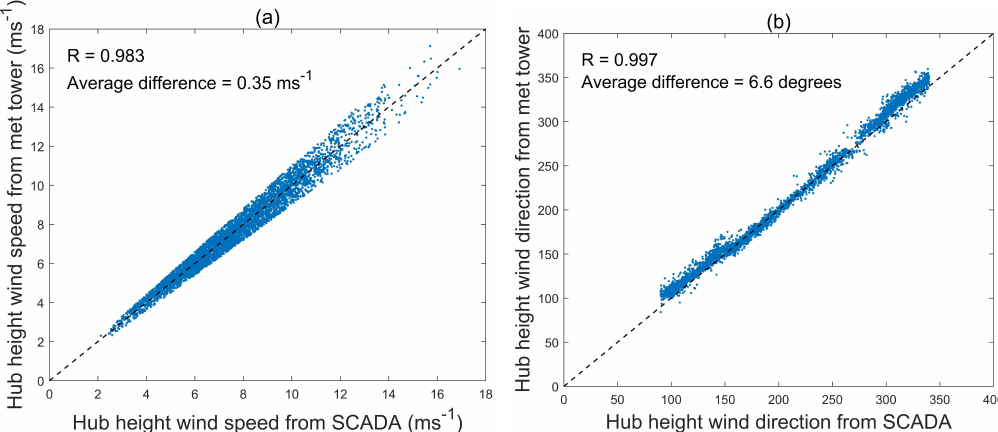
Figure 6. Ten-minute averaged Hub height ( a ) wind speed and ( b ) wind direction measurements from SCADA and met tower data after preliminary quality checks. The dashed diagonal line shows a 1:1 relationship. It should be noted that wind direction at hub height from met tower was not available during the period of study due to sensor failure, and it was interpolated from wind direction at 32 m and 105